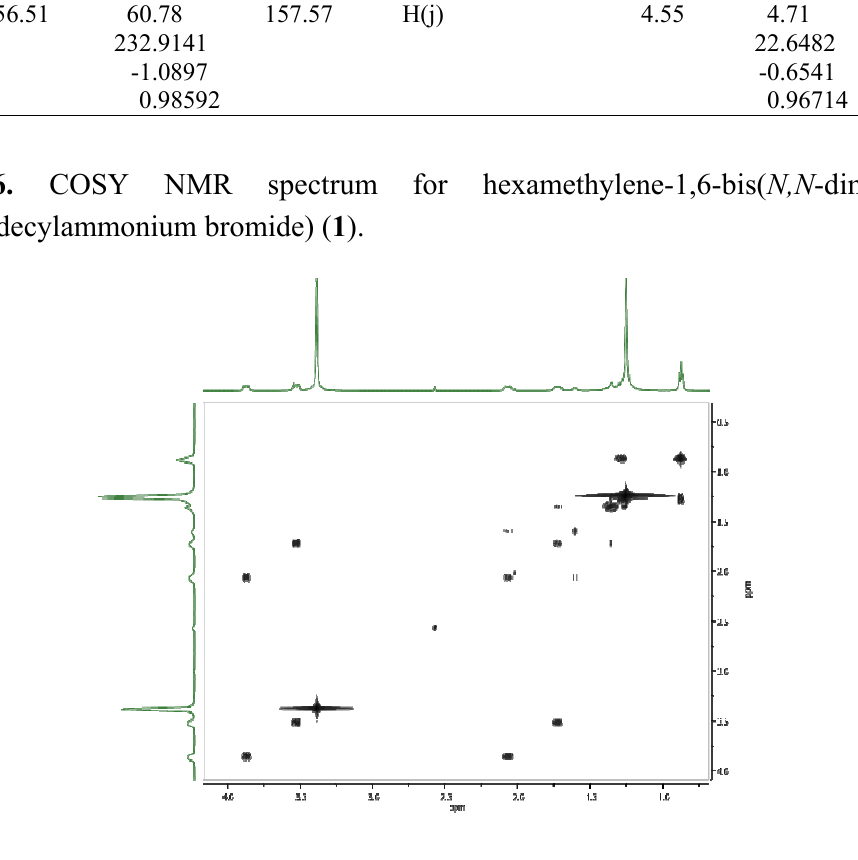
Figure 7. Experimental chemical shifts ( δ dimethyl- N -dodecylammonium bromide) ( 1 ) vs . the isotropic magnetic shielding ( σ from the GIAO/HF/3-21G(d,p) calculations for molecules δ